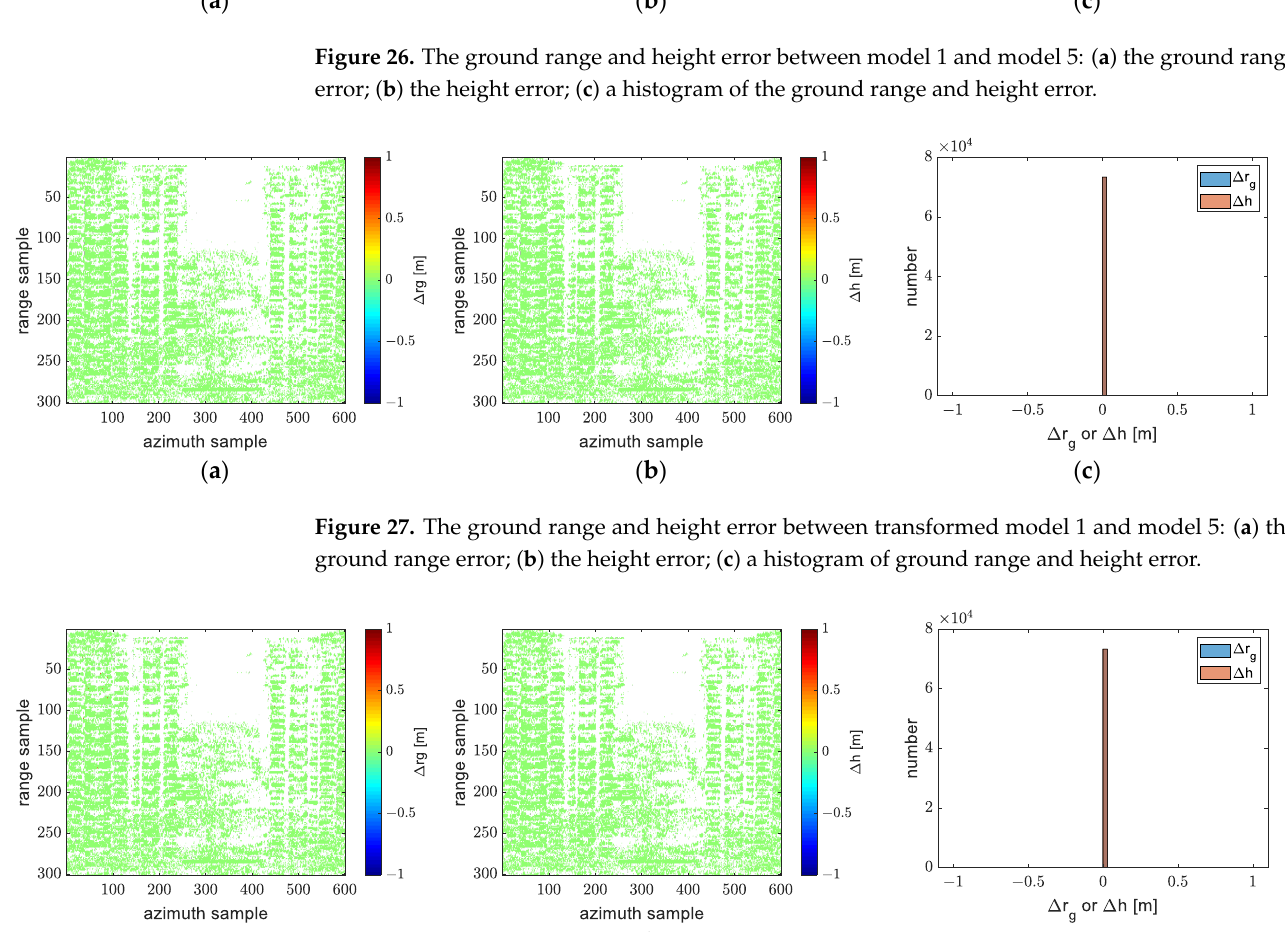
Figure 26. The ground range and height error between model 1 and model 5: ( a ) the ground range error; ( b ) the height error; ( c ) a histogram of the ground range and height error.